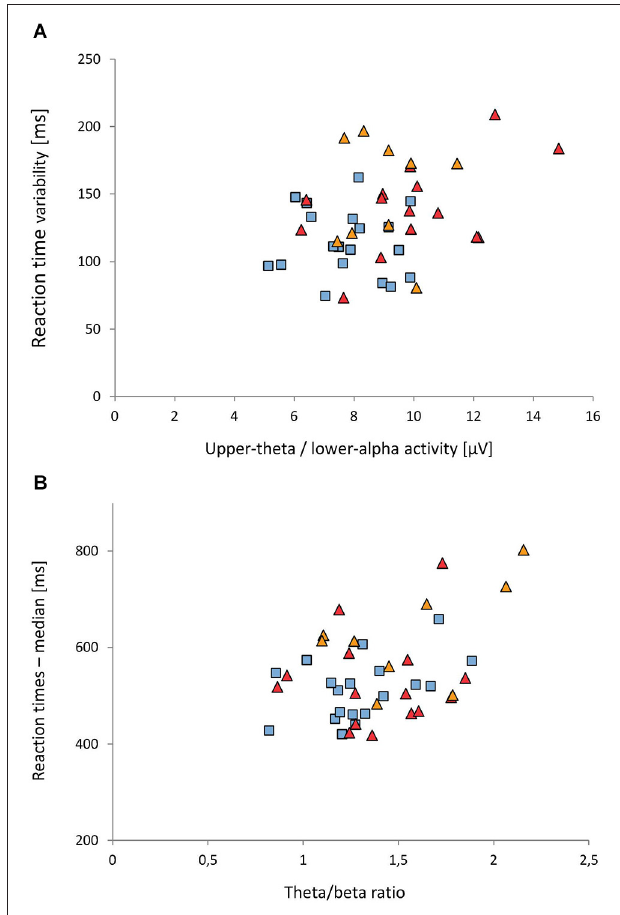
FIGURE 4 | Associations between EEG and reaction time measures. (A) Upper-theta/lower-alpha (5.5–10.5 Hz) activity vs. reaction time variability. (B) Theta/beta ratio vs. median of reaction times. Reaction time measures were adjusted for developmental effects (for details see text). Control group: blue rectangles; ADHD-C group: red triangles; ADHD-I: orange